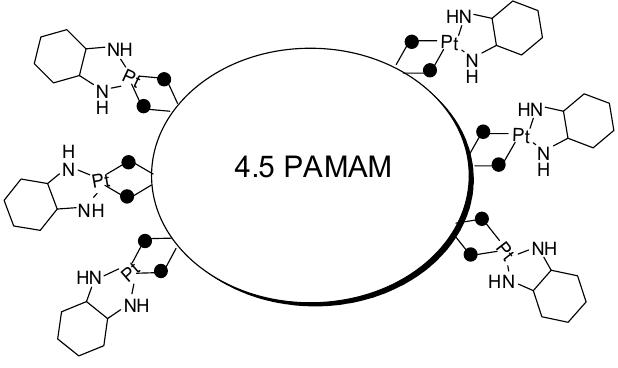
Figure 14. Polymeric prodrug potentially active in cancer [65].